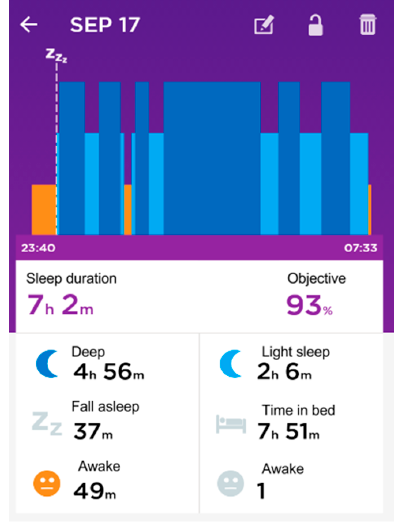
Figure 11. Sleep analysis by Jawbone through the Jawbone Up move.